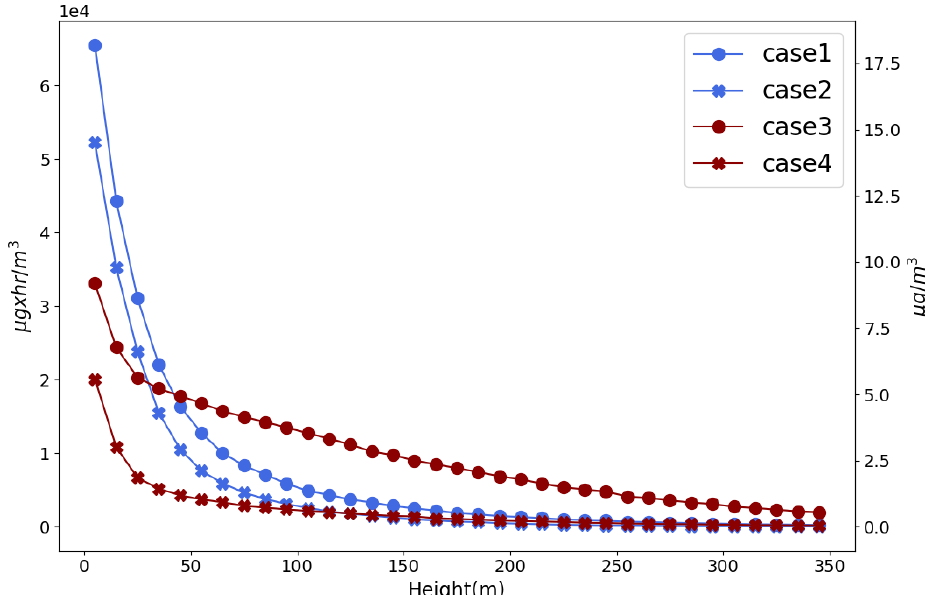
Figure 6. The accumulate and instantaneous concentration profile (left and right vertical axis) induced by traffic sources for all cases described in Table 1 is